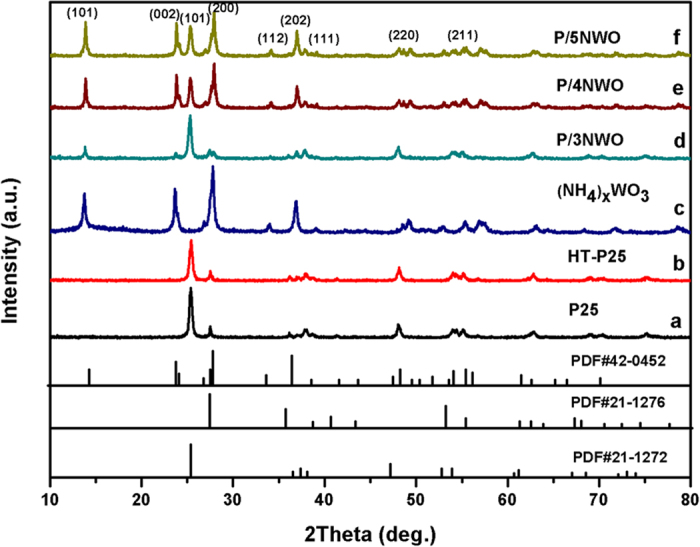
XRD patterns of pure (a) P25, (b) HT-P25, (c) (NH4)xWO3 and different P/NWO nanocomposites: (d) P/3NWO, (e) P/4NWO, (f) P/5NWO.